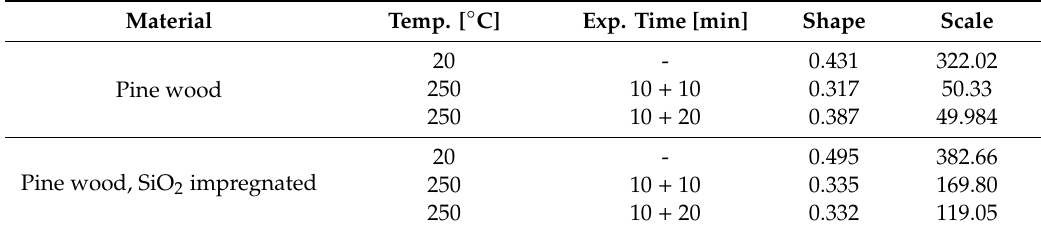
Table 3. Parameters of shape and scale in the Weibull distribution.